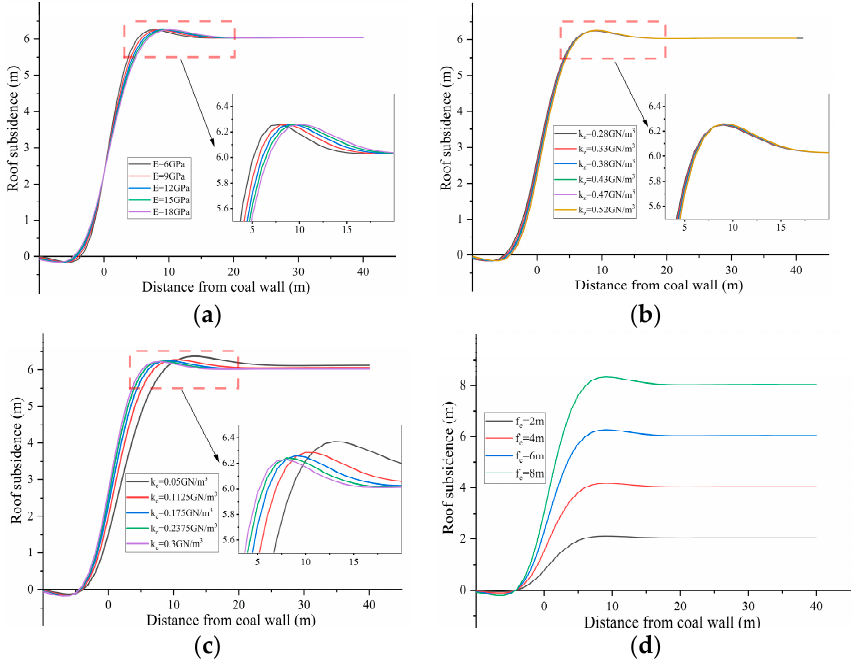
Figure 4. ( a ) Influence of elastic modulus of the direct roof on roof subsidence. ( b ) Influence of elastic foundation coefficient of support on roof subsidence. ( c ) Influence of elastic foundation coefficient of filling body on roof subsidence. ( d ) Influence of height of the gap between filling body and roof on roof subsidence.